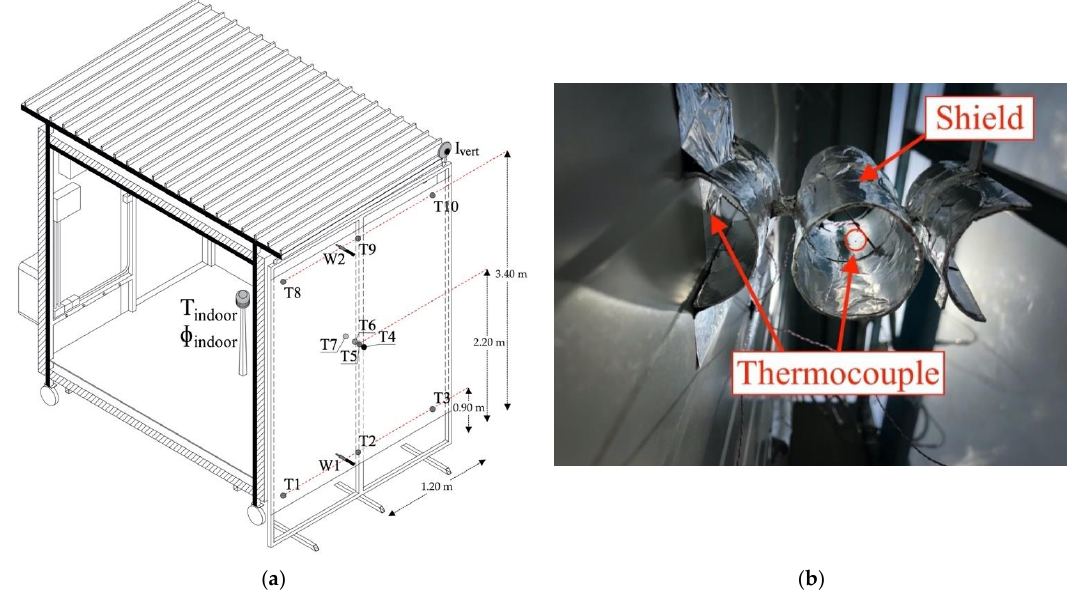
Figure 2. ( a ) Axonometric views of the sensor layout; ( b ) shielding devices used in the experimental setup to avoid any direct solar radiation on the thermocouples. In order to verify the measurement methodologies and characterize each test cell from the thermal point of view, preliminary data has been acquired in a standard config- uration (both Gemini s without a second-skin system). These data are recorded with the aim of (i) verifying the operation of the different instruments and their correct positioning, (ii) comparing the thermal behavior of the two test cells, and (iii) defining a reference point for the following evaluation of the real performances of double-skin facades or smart win- dows. The preliminary experimental data were acquired and stored every 1 min on a pe- riod of 1 month (from 1 June to 30 June) and, later, averaged on an interval of 15 min. Figure 3 reports the indoor air temperature of Gemini 1 and Gemini 2, the external air temperature, and the global horizontal radiation for three typical days in June. This figure highlights that the difference between the indoor air temperature of Gemini 1 and the indoor air temperature of Gemini 2 ( T indoor, Gemini 1 – T indoor, Gemini 2 ) is negligible, varying within an interval with a maximum of 0.2 °C and a minimum of −0.2 °C. After the preliminary experimental campaign, a second-skin system has been mounted and tested on a test cell (Gemini 1) with an air cavity gap equal to 0.10 m, while the other cell has been left unequipped and used as a reference (Gemini 2). In particular, the investigated second-skin system has been realized with extruded ABS panels [54]. The experimental data were acquired and stored every 1 min over a period of 1 month (from 8 December to 31 December) and, later, averaged on an interval of 15 min. This experi- mental campaign aims to verify the performances of plastic panels as a second-skin layer for innovative envelopes. The extruded ABS panels have been selected with dimensions equal 600 mm × 1200 mm; such dimensions have been selected on the basis of the dimension of conventional panels in OVF systems, in order to guarantee an easy installation in a commercial OVF structure, as well as an easy substitution of conventional OVF system materials in a real- istic scenario. In Figure 4a, a detailed view of the analyzed extruded ABS panel before the installation is displayed, while Figure 4b shows the Gemini 1 equipped with the second- skin realized with six extruded ABS panels.